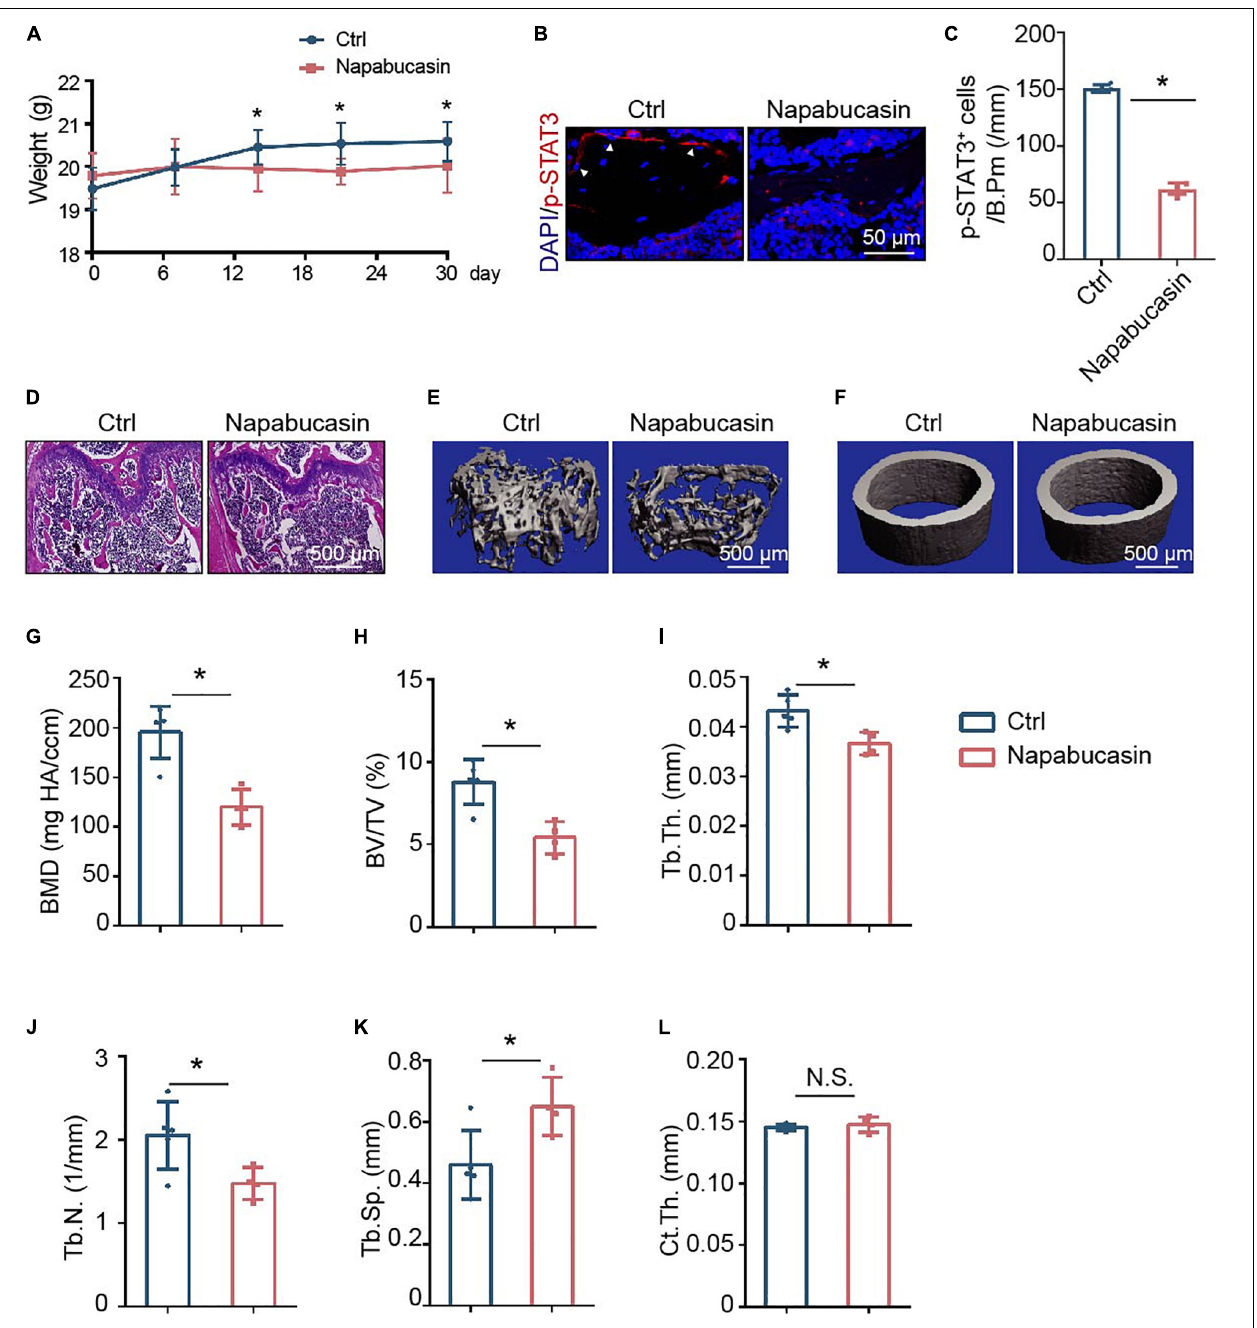
FIGURE 4 | Napabucasin injection caused osteoporosis in mice. (A) Representative immunofluorescence image of pSTAT3 staining in the femurs of mice injected with vehicle or Napabucasin (10 mg/kg). (B) Number of pSTAT3 + cells were counted. N = 5. Data are represented as means ± S.D. * P < 0.05. (C) Body weights of mice injected with vehicle or Napabucasin (10 mg/kg) were recorded on different days. (D,E) Three-dimensional micro-CT reconstruction images of trabecular bone (D) and cortical bone (E) of femora from the above mice. (F–K) Quantitative microarchitectural parameters from micro-CT. N = 5. Data are represented as means ± S.D. * P < 0.05. (L) HE staining of femora from the above